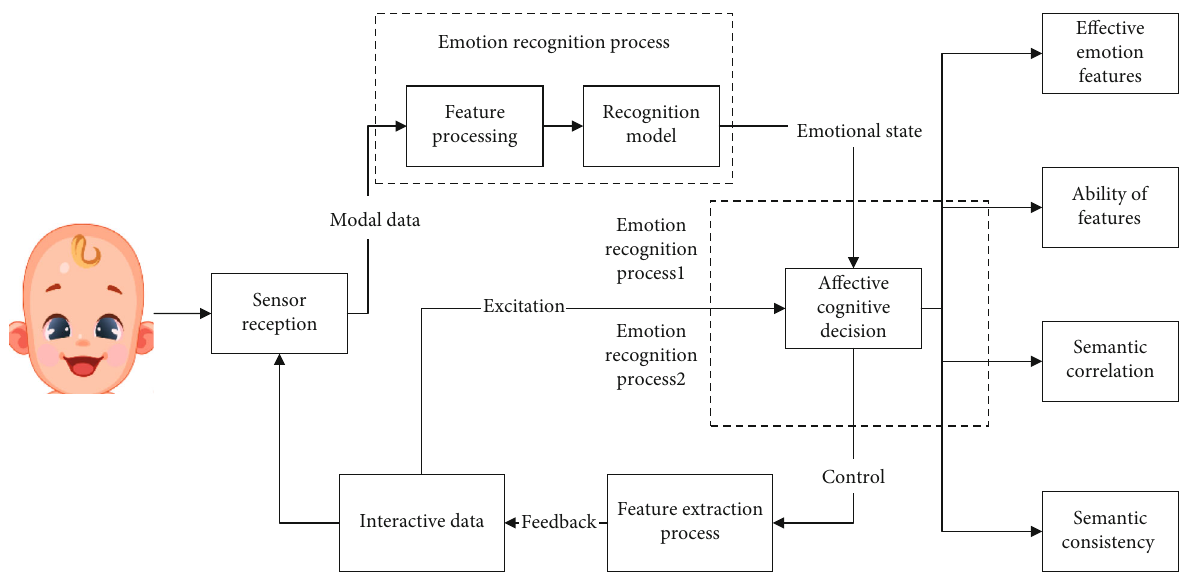
Figure 1: The closed-loop process of emotional